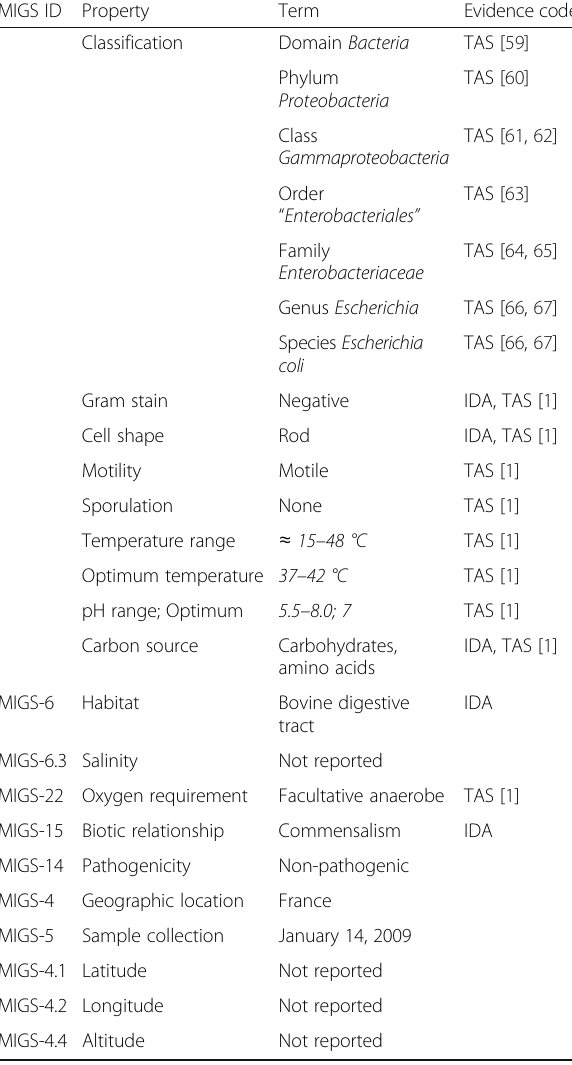
Table 1 Classification and general features of E. coli BG1